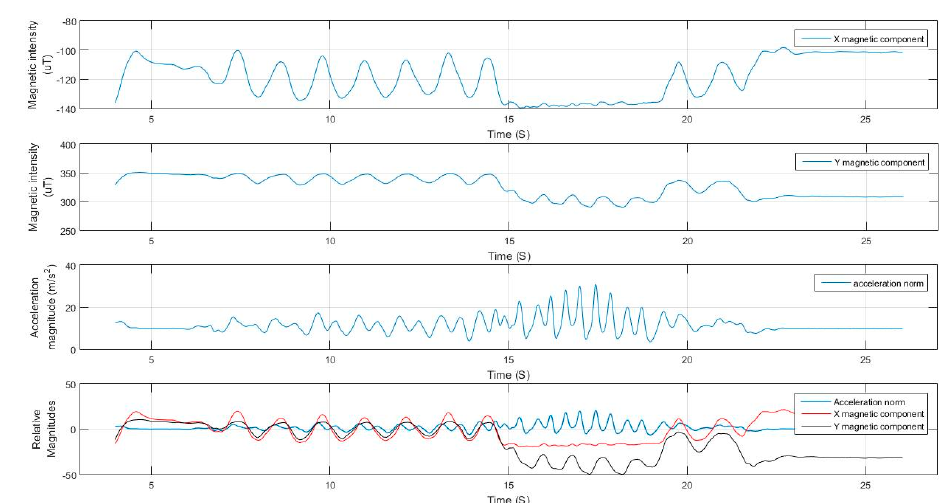
Figure 13. Magnetic intensity components during swinging. Sensors 2017 , 17 , 2573